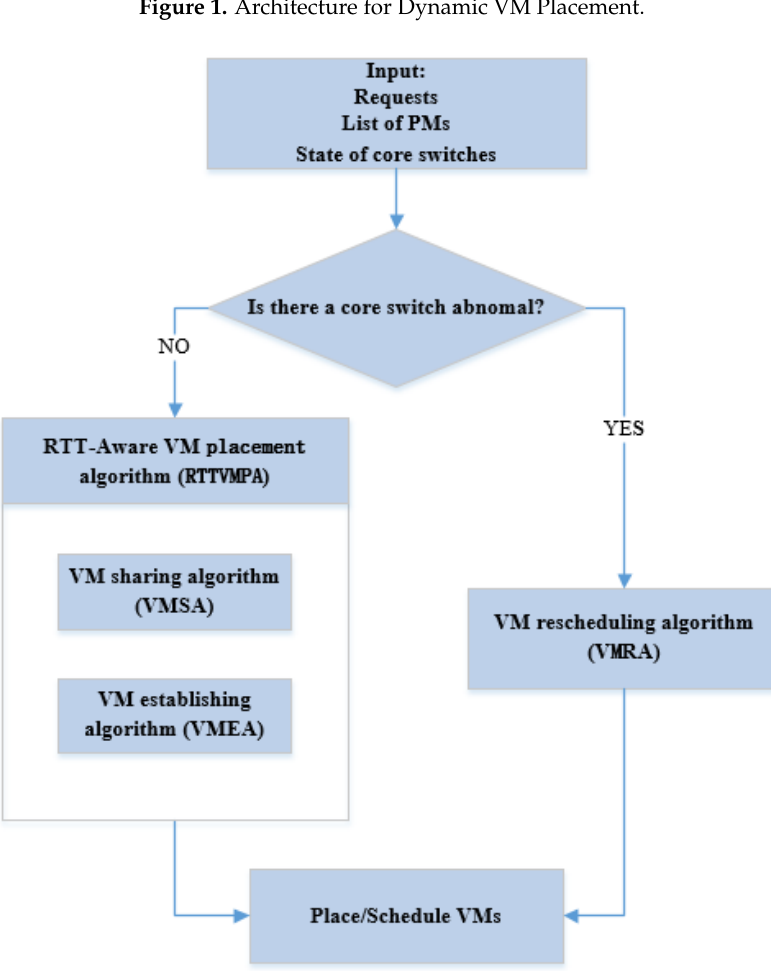
Figure 2. Overview of Proposed Algorithms.